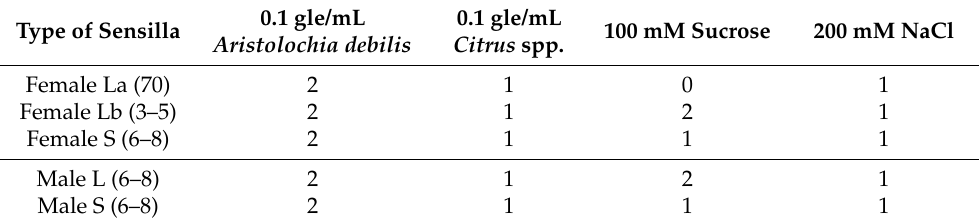
Table 1. Number of cells responding to various stimulants in Atrophaneura alcinous adults. Type of